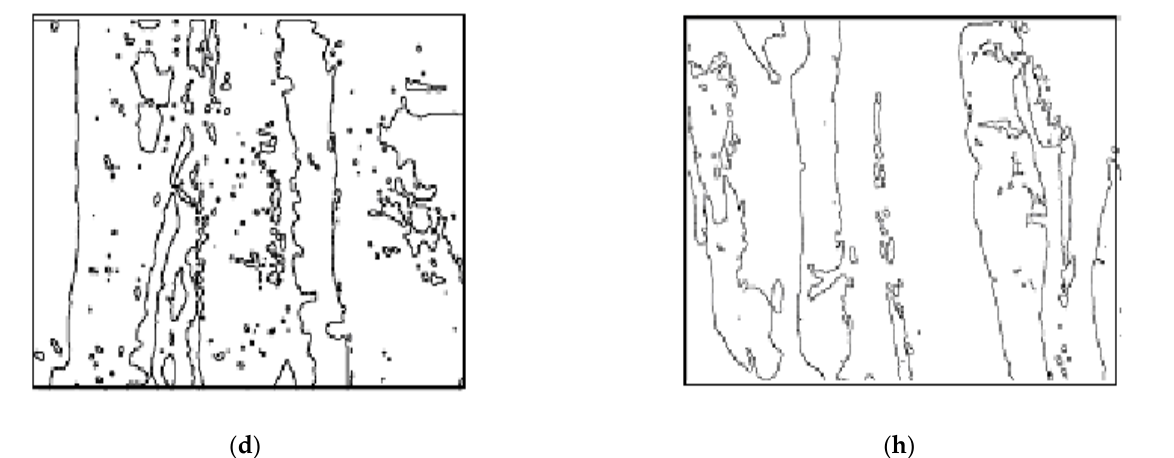
Figure 11. Segmentation results: (Case 2) Chitosan/Silica Nanoparticle (CH-SN); image origin ( a ), sobel edge extraction ( b ), image classified 2 classes ( c ), and image segmented ( d ). (Case 3) Chitosan/Silica Nanoparticle/Nisin (CH-SN-N); image origin ( e ), Sobel edge extraction ( f ), image classified 2 classes ( g ), and image segmented ( h ). Table 4. Comparison of the morphological characteristics.